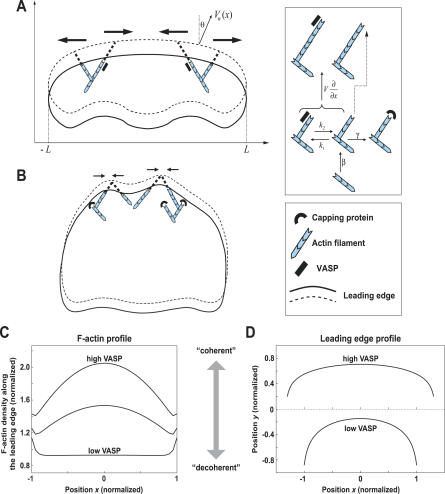
Mathematical Modeling Explains the Coherent and Decoherent Keratocyte Phenotypes(A) In coherent cells, long actin filaments are protected from capping and undergo significant lateral flow (arrows), smoothing heterogeneities at the leading edge. According to the Graded Radial Extension model, V
n(x)=V cosθ, where V represents cell speed, V
n represents the local protrusion rate, and θ is the orientation of the normal to the leading edge at position x. Quantitative actin dynamics (right) are explained in the Materials and Methods and Text S1.(B) In decoherent cells, short filaments that are not protected from capping undergo less-extensive lateral flow (arrows) and may focus into heterogeneities at the leading edge causing the unstable protrusion of microregions.(C) Barbed end density and nascent filament branching were chosen so that when VASP activity is low, the F-actin density along the leading edge appears flat (bottom curve). When high VASP activity was entered into our model, the F-actin density along the leading edge emerged as an inverted parabola (top curve), with F-actin density peaked in the middle, as observed experimentally in coherent cells. Position is normalized by the half-length of the leading edge. The prediction that peaked F-actin density is proportional to the level of VASP is qualitatively consistent with the experiment (see Figures 4C and 4D).(D) Based on protrusion rate as a function of barbed end distribution along the leading edge, the computed leading edge profile is wide (canoe-shaped) in coherent cells with high VASP at the leading edge (top curve) and short (D shaped) in decoherent cells with low VASP at the leading edge (bottom curve). Position (x) is normalized by the half-length of the leading edge of the short, decoherent cell. The same scale is used for the coherent cell, which is 30% longer, so the corresponding profile extends beyond 1.